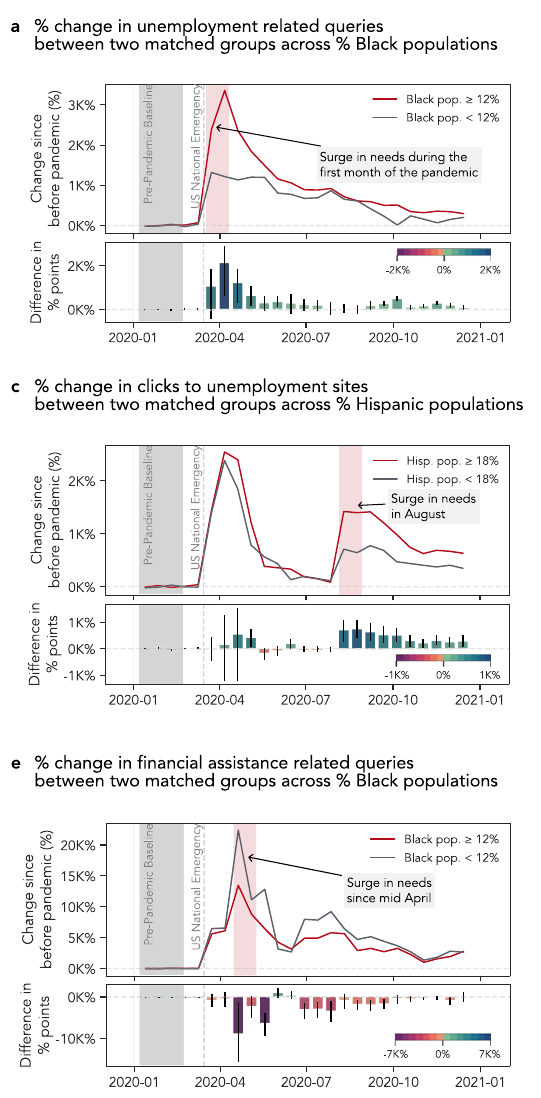
observe that ZIP codes with higher proportions of Black and Hispanic residents experience a greater change in clicks in unemployment sites during the month of August,butZIPcodeswithloweducationalattainmentexpresslesschangeinclicks in unemployment sites. e Search queries related to fi nancial stimulus were at their peakin late April,right after the time thatthe fi rst stimulus checks weredeposited on April 11. f However, throughout the year and especially during the four weeks sincemid-April,ZIPcodeswithhigherproportionsofBlackresidentsexperienceda smaller change in fi nancial stimulus-related queries than ZIP codes with lower proportions of Black residents. In all bar charts in a – f , data are presented as mean values, and error bars indicate 95% con fi dence intervals (1603 ≤ n ≤ 12,575, Sup- plementary Table 6 for sample sizes per SDoH factor). Both mean values and con fi dence intervals are obtained through bootstrapping with 500